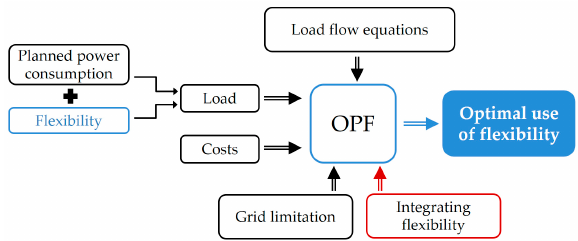
Figure 5. Modified Optimal Power Flow (OPF) calculation with input and output as well as constraints.